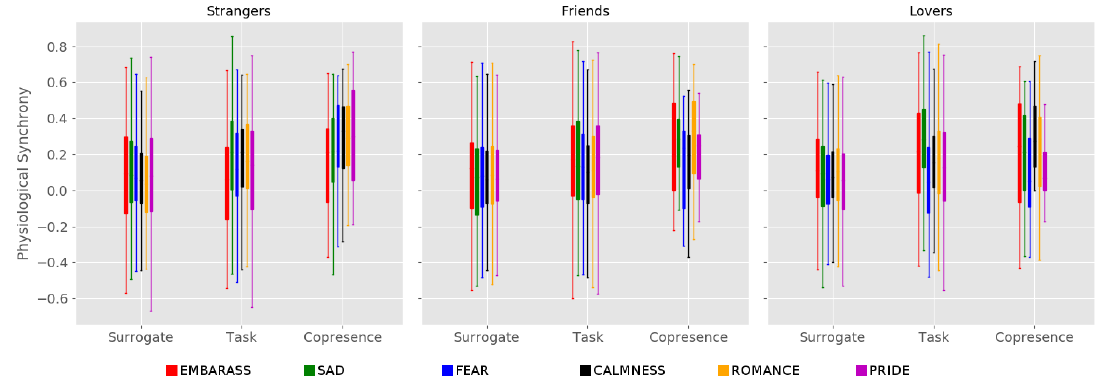
Figure 2. Distribution of the three types of physiological synchrony for each group of relationship and